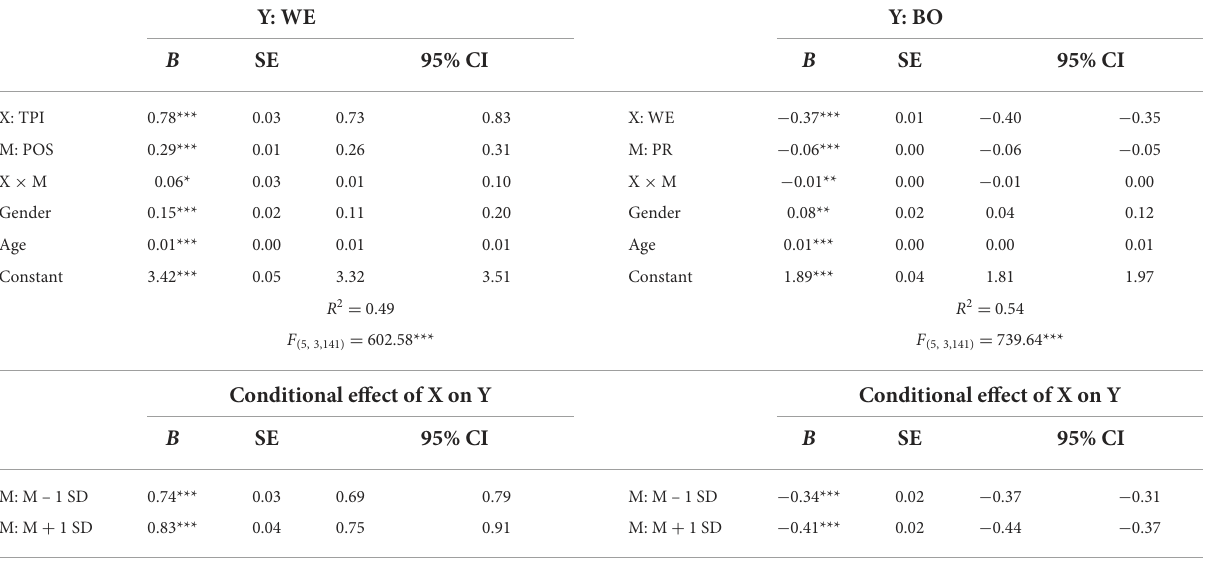
TABLE 2 Results of the moderation analyses.